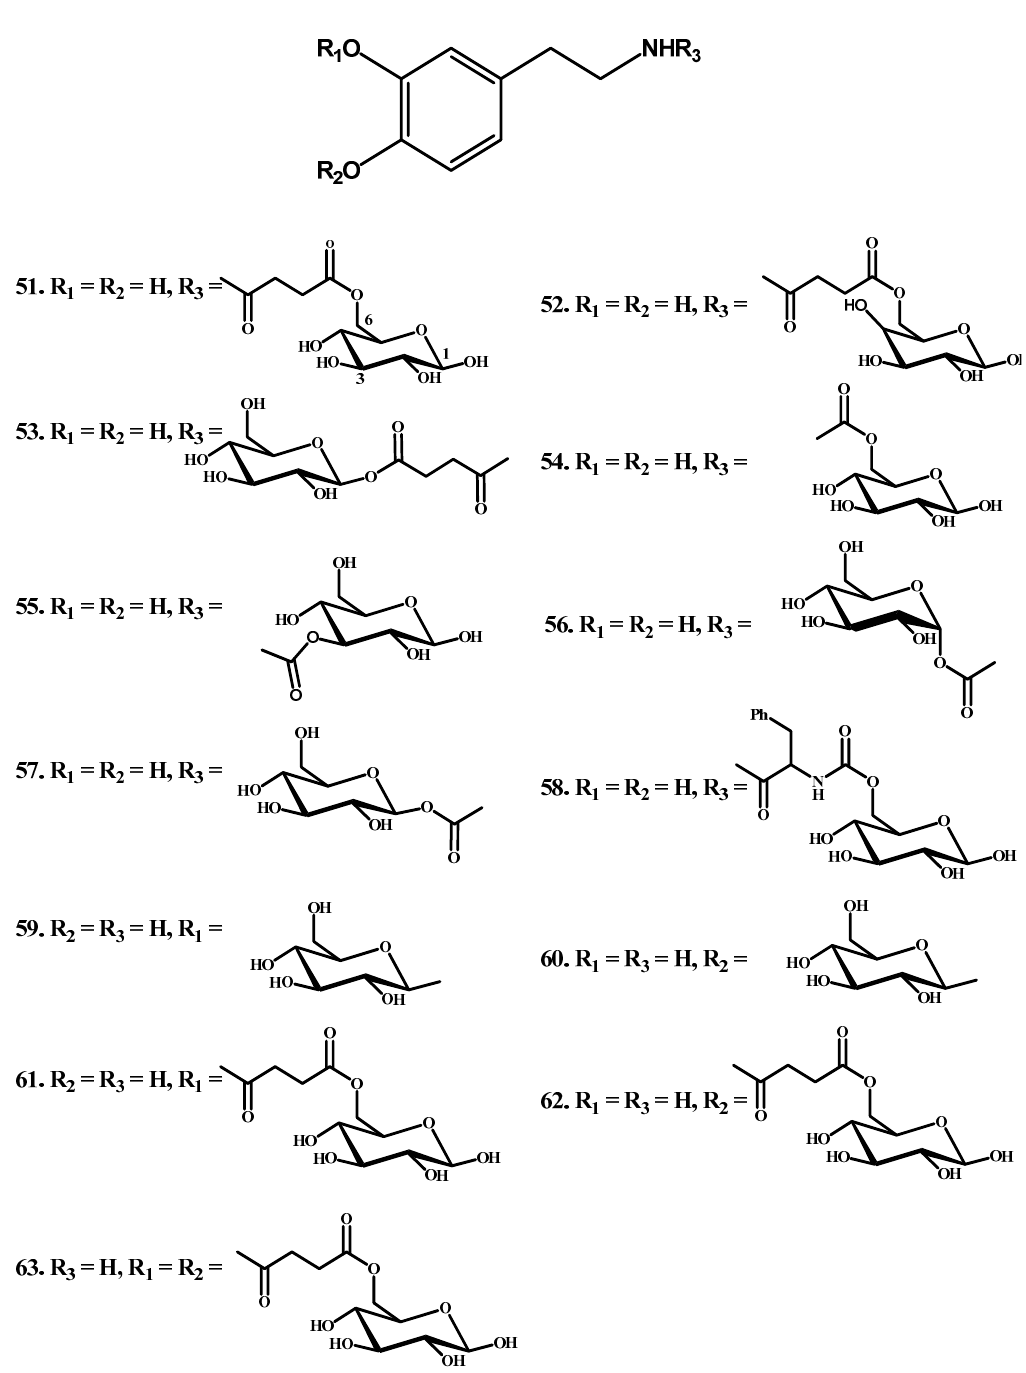
Figure 8. Glycosyl DA derivatives, 51 – 63 .